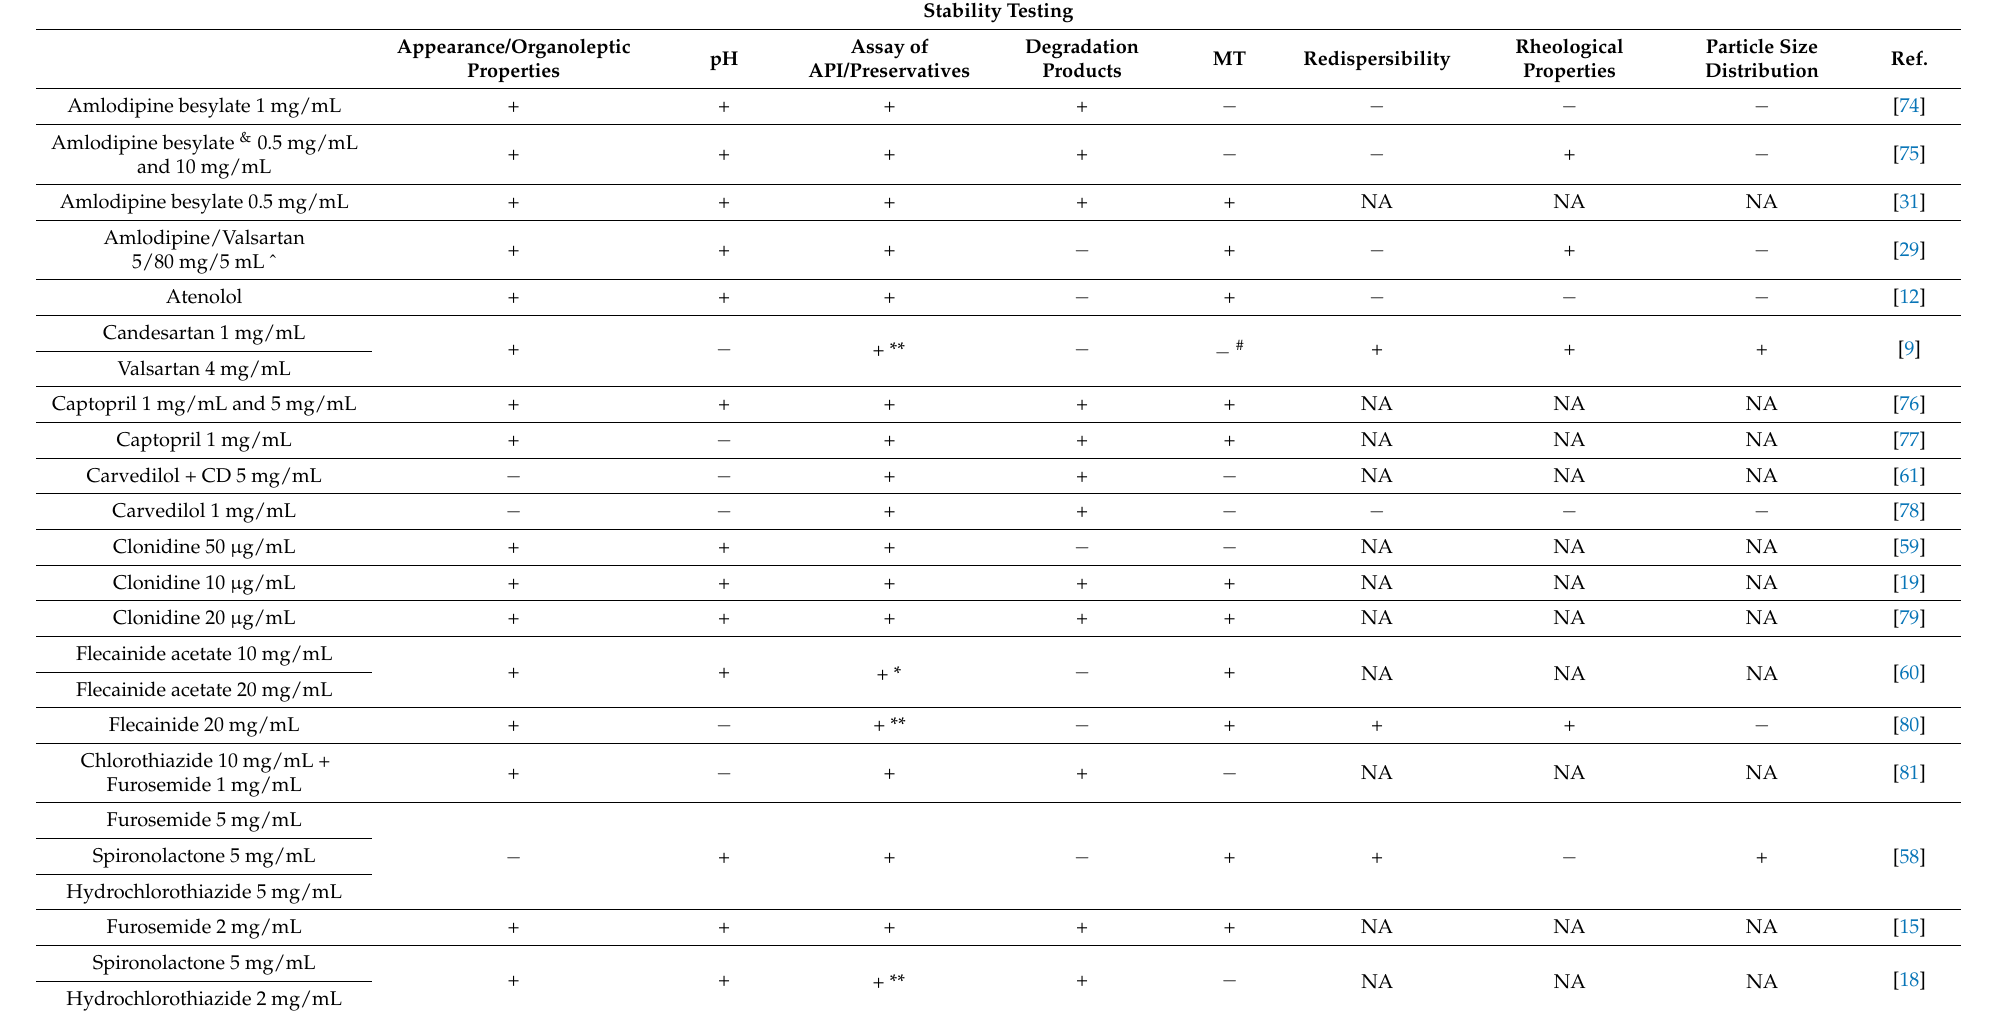
Table 2. Stability-indicating